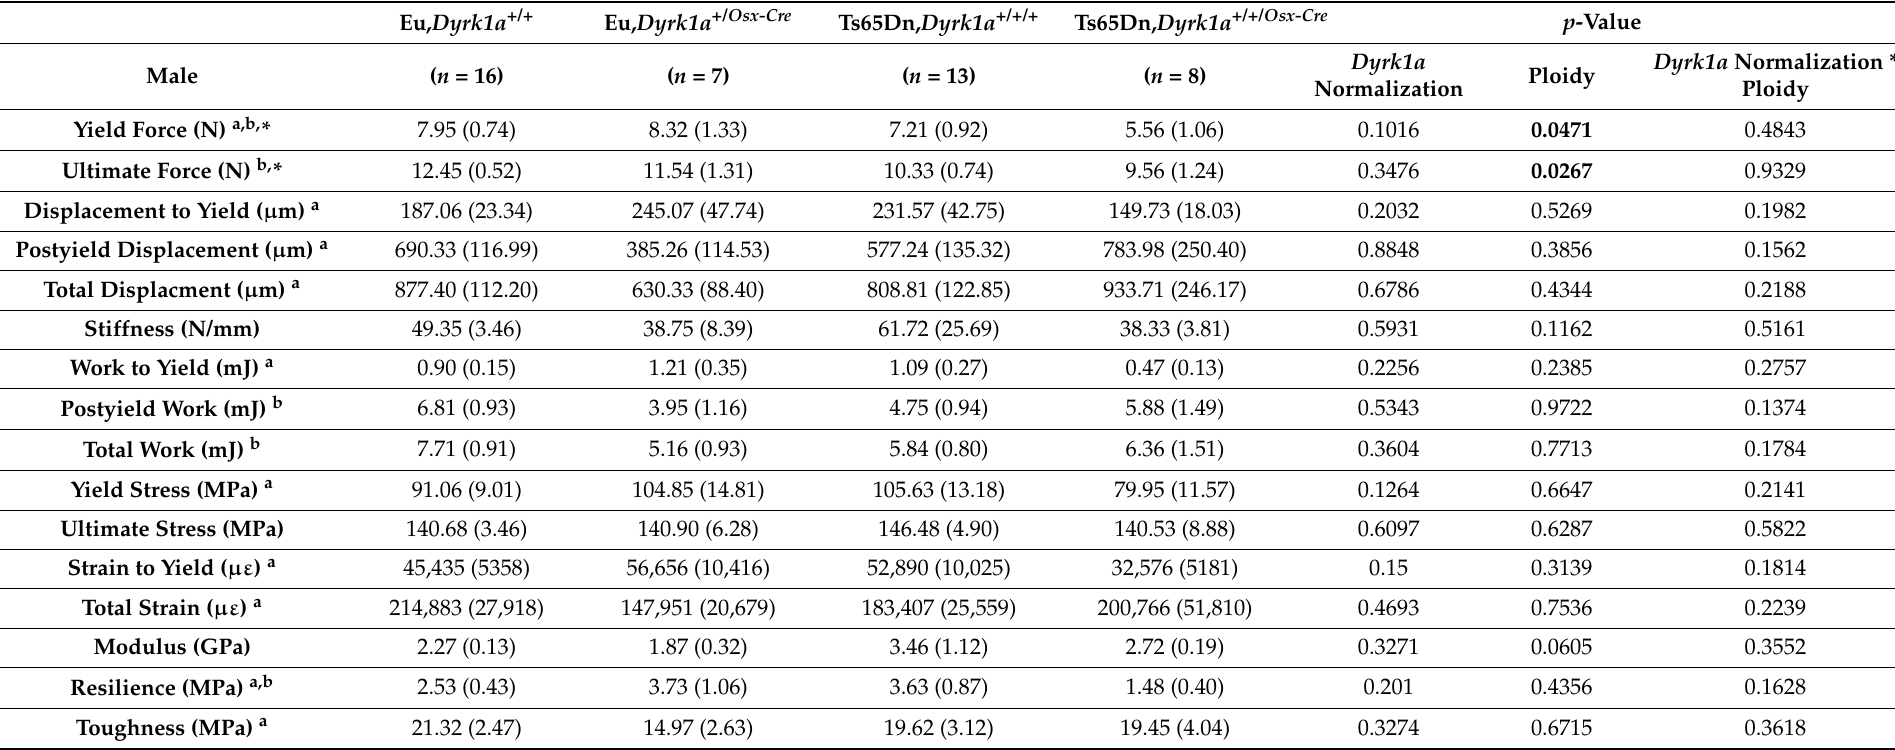
Table 2. Mechanical testing for 6-week-old male euploid and trisomic Ts65Dn